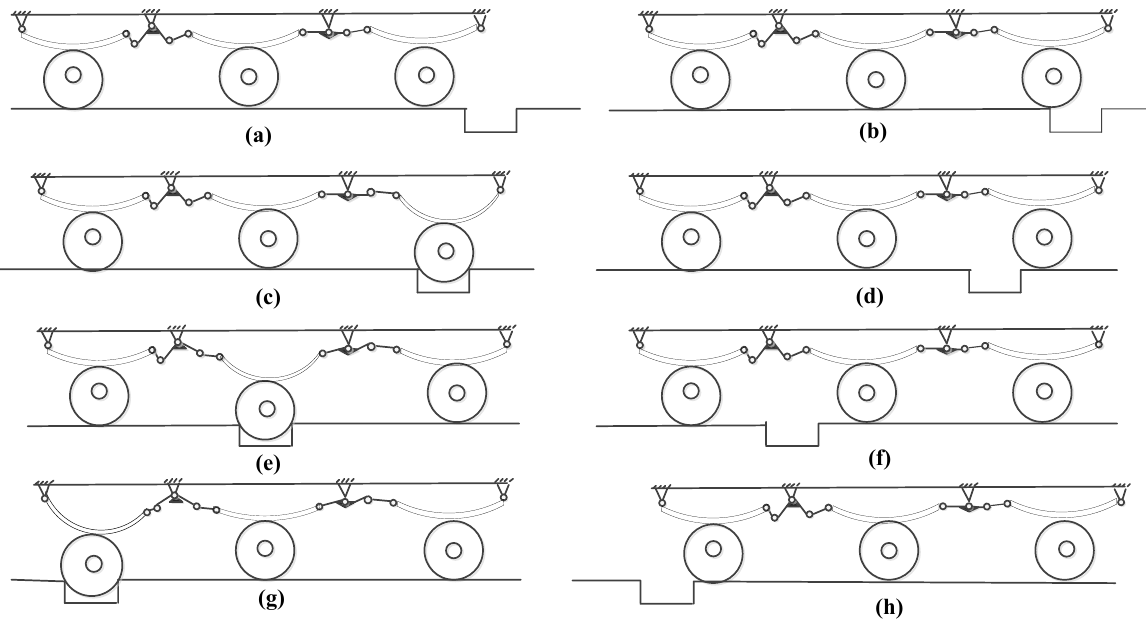
Figure 7. Process of crossing the trench: ( a – c ) the process of front wheel crossing the trench; ( d,e ) the process of middle wheel crossing the trench; ( f – h ) the process of rear wheel crossing the trench.